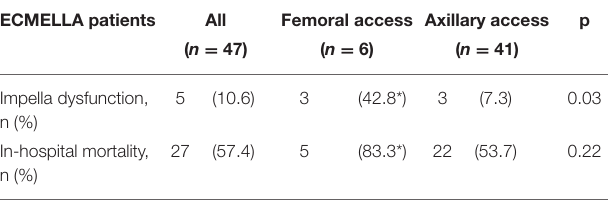
TABLE 4 | Representative outcomes in 47 ECMELLA patients depending on access site. ECMELLA